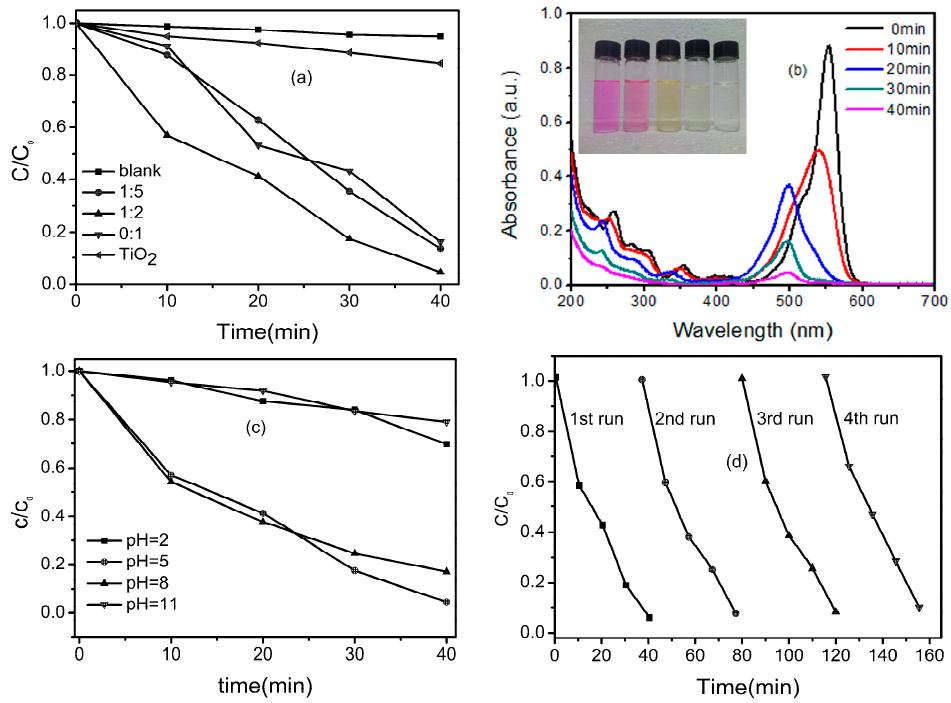
Figure 7. ( a ) Photocatalytic activities on degradation of RhB from Bi 2 WO 6 samples obtained at different volume ratio of ethylene glycol (EG) and ethanol (EA) in reaction solution. ( b ) The temporal evolution of the absorption spectra of the RhB solution under visible ‐ light irradiation in the presence of 100 mg hierarchical hollow Bi 2 WO 6 microspheres, the insert is the corresponding time-dependent color changes of the RhB solution. ( c ) Photocatalytic performance on degradation of RhB in aqueous solution with various pH values. ( d ) Cyclability of photocatalytic activity from hierarchical hollow Bi 2 WO 6 microspheres under visible ‐ light irradiation.